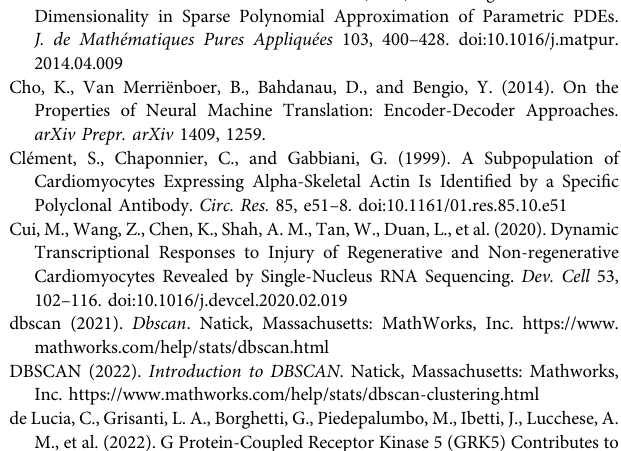
vars.to.regress set to nUMI and nGenes; then, the scaled expression was log- normalized. Supplementary Figure S3 | Pairwise similarity among cardiomyocyte CM1-CM10 clusters. The cluster similarity was calculated by averaging 1000 cell-cell similarity scores, whereas the cells were randomly selected in each cluster. The left-side bar maps the color to the similarity score, where more red implies a higher degree of similarity. Supplementary Figure S4 | Cardiomyocyte cell-cycle gene expression tended to be greater in ARP1, MIP28, and ARP1MIP28 hearts from P30-P42 than in CTL hearts on P28. Sparse analysis was conducted for the expression of genes associated with the G01, G1S, S, G2M, M, and MG1 phases of the cell cycle, and the proportion of cardiomyocytes with high levels of expression was calculated for each experimental group and time point. Supplementary Figure S5 | Schematic representation of the autoencoder model. The autoencoder constructed for the analyses presented here consisted of an input layer,acentralembeddedlayer,andanoutputlayer.Theinputlayerincluded14,753 genesandwasalternatelyencoded intoa10-dimensionalembeddedlayerandthen decoded into a synthetic output layer comprising the same genes present in the input layer. The accuracy of the embedded layer was optimized by minimizing the indicated function. Supplementary Figure S6 | Cell localization in each sample group ’ s cardiomyocyte. Here, the umap plots for all cells were drawn, and the cells were colored based on: whether the cell belongs to a speci fi c sample group (red) or the cell belongs to other sample groups. The order, from left to right and from top to bottom, is: CTL-P28, ARP1-P28, MIP28-P30, ARP1-MIP28-P30, MIP28-P35, ARP1-MIP28-P35, MIP28-P42, ARP1-MIP28-P42, MIP28-P56, ARP1-MIP28- P56, Fetal, CTL-P1, CTL-P56, and ARP1-P56. Supplementary Figure S7 | Algorithm-quality analysis con fi rming that the parameter combination (minpts = 30, epsilon = 0.3) in UMAP toolkit is robust. (A) The 30th-neartest-distance plot show that the “ elbow ” point, which determine the optimal epsilon parameter (according to [92]) is approximately 0.3. (B) The preserved clusterlandscapedrawbyslightlychangingtheparameters: minpts =25, 30, 35, and epsilon = 0.25, 0.3, 0.35. Supplementary Figure S8 | Summary of Immuno fl uorescence image processing. (A) Thestainingimages(red:GRK5,green:cardiactroponincTnT)wererepresented in red(R)/green(G)/blue(B) channel matrices. (B) Image segmentation was performed on the blue channel, which divided the image into the background (nocTnT,black)andforeground(withcTnT,white). (C) Theredchannelbackground distribution was plotted to determine a background baseline. This distribution had three scenarios. Top: near-zero distribution, the baseline (indicated by the dashed line) = 0; middle: one distribution form, the baseline = average of red channel background; bottom: the two or more distributions appeared, then the baseline = average of the largest (most right) distribution. (D) the red channel (GRK5) was adjusted by subtracting this channel from the background